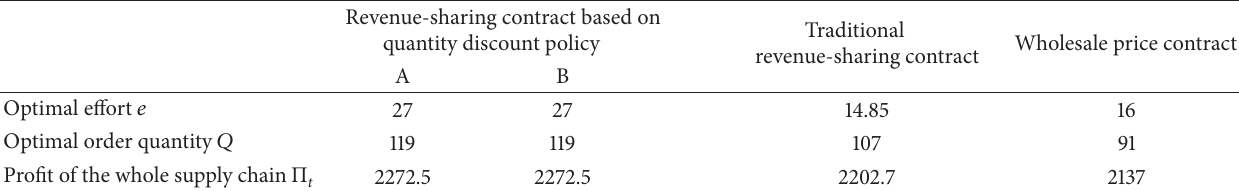
Table 1: The parameters of supply chain in different modes with only retailer bearing effort